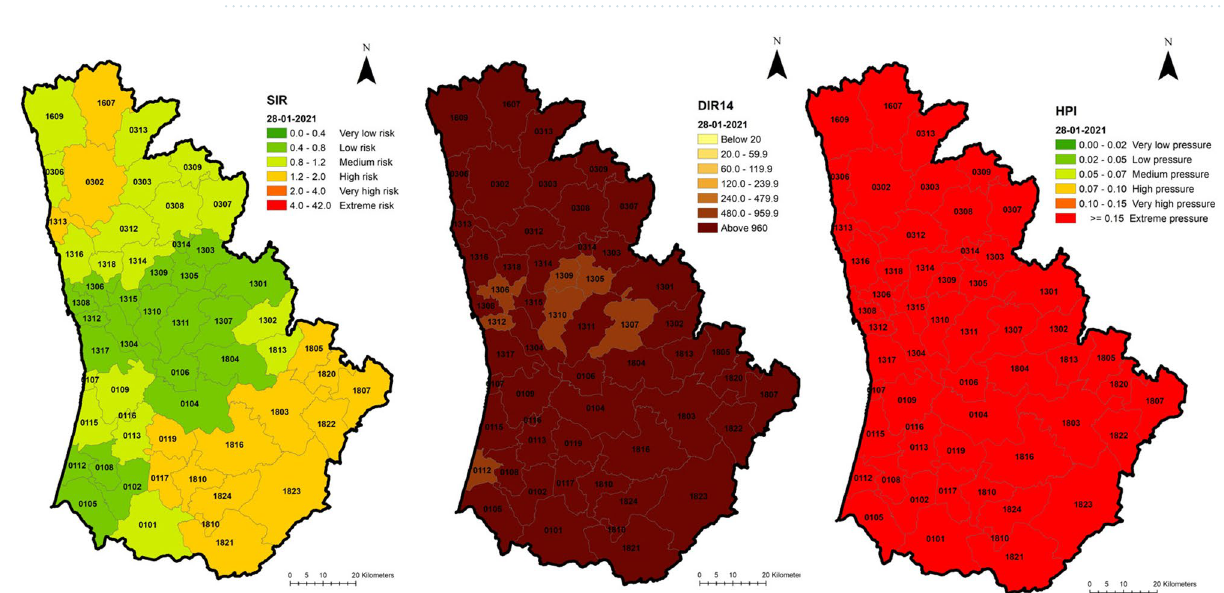
Figure 5. Spatial distribution of SIR, DIR14 and HPI, 28/01/2021, Portuguese mainland.